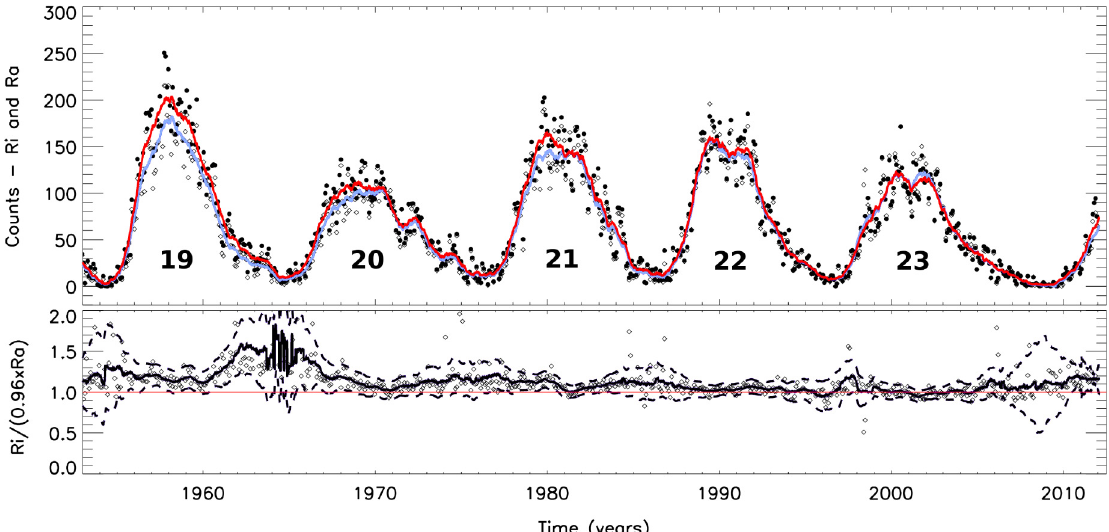
Fig. 2. Comparison of the international sunspot index R i with the American sunspot number R A produced by the AAVSO since 1945. Top panel: monthly R i and R A values (black and white dots respectively) and 1-year smoothed average R i and R A values (red and blue curves respectively). The cycle numbers are indicated. Bottom panel: monthly ratios R i = R A (diamonds) and the 1-year smoothed ratio (solid line) with the 3 r confidence levels (dashed lines).